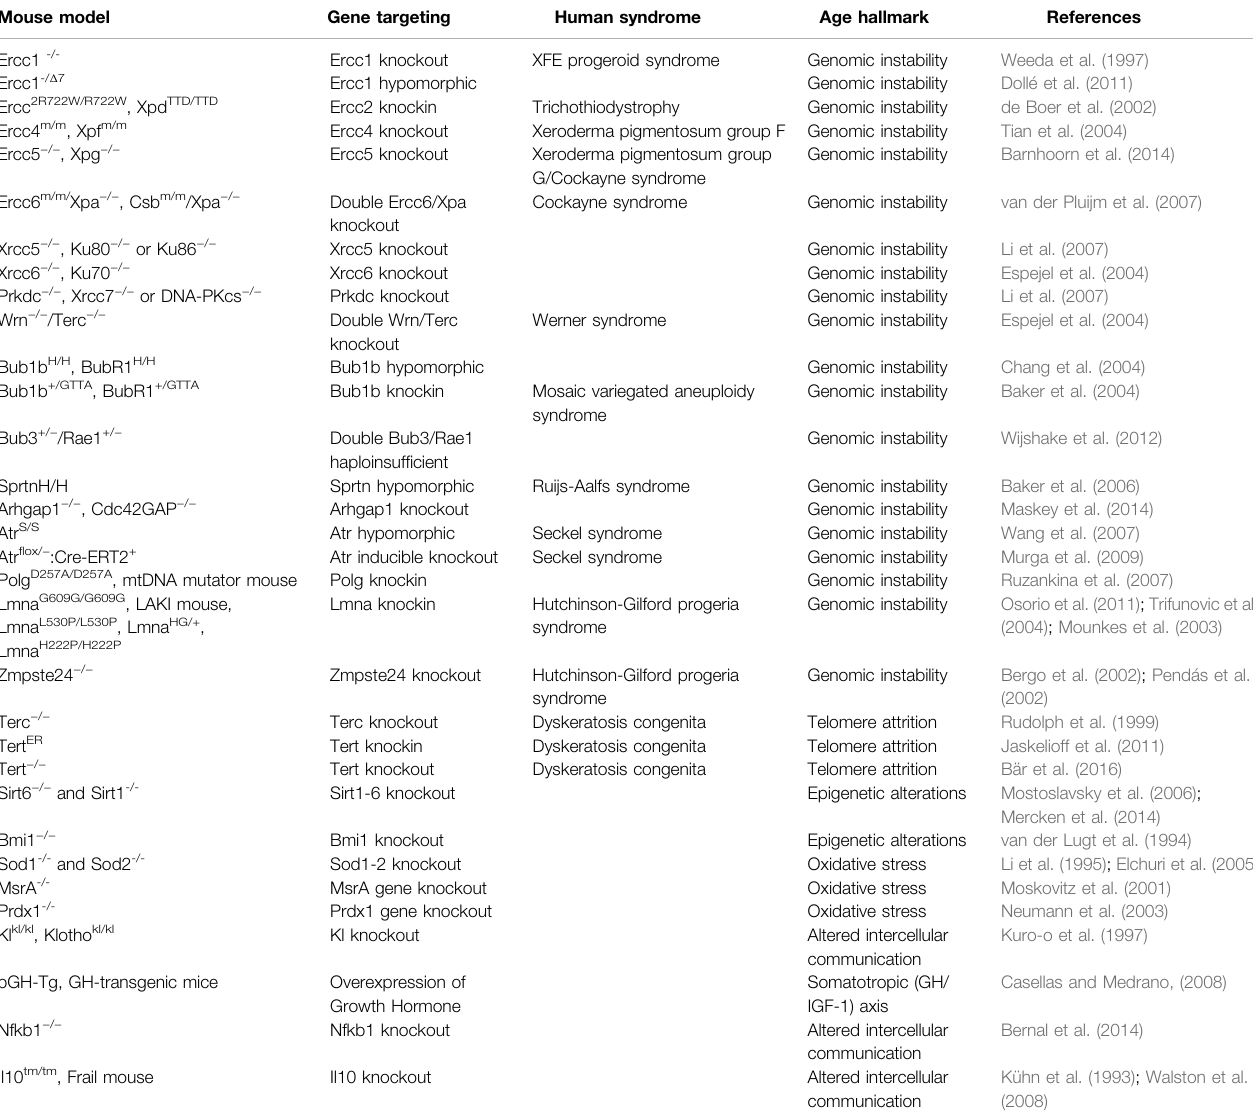
TABLE 1 | Genetically-engineered mouse models regularly used in aging research and the age-distinguishing characteristic (hallmark) in males and females. Mouse